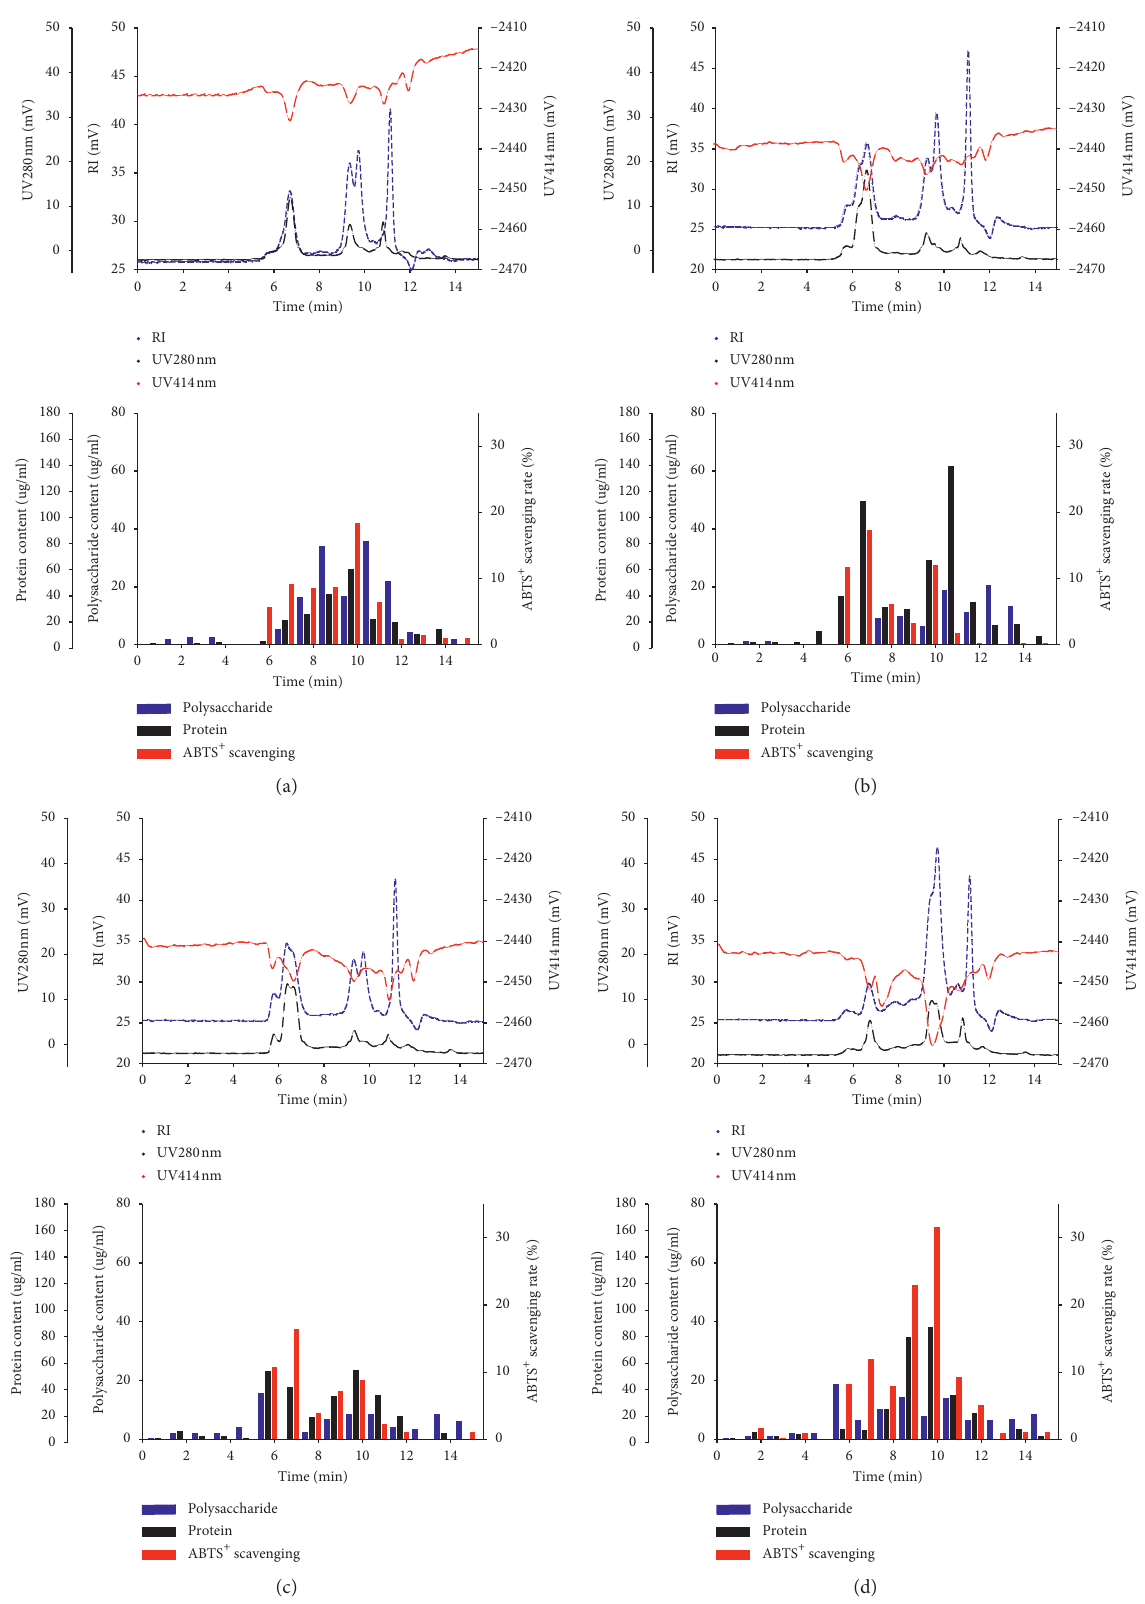
Figure 3: Elution profile HPLC and online HPLC–UV–ABTS +chromatography, respectively, on the PNMP extract produced by: (a) ultrasonic extraction, (b) microwave extraction, (c) hot water extraction, and (d) homogenate